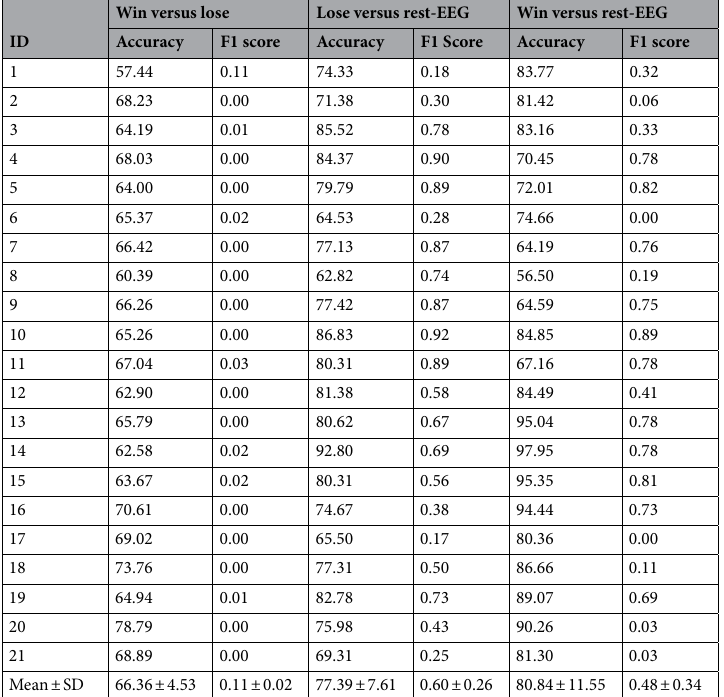
Table 5. The accuracy and F1 score for each classification problem obtained through permutation and random feature assignment for each